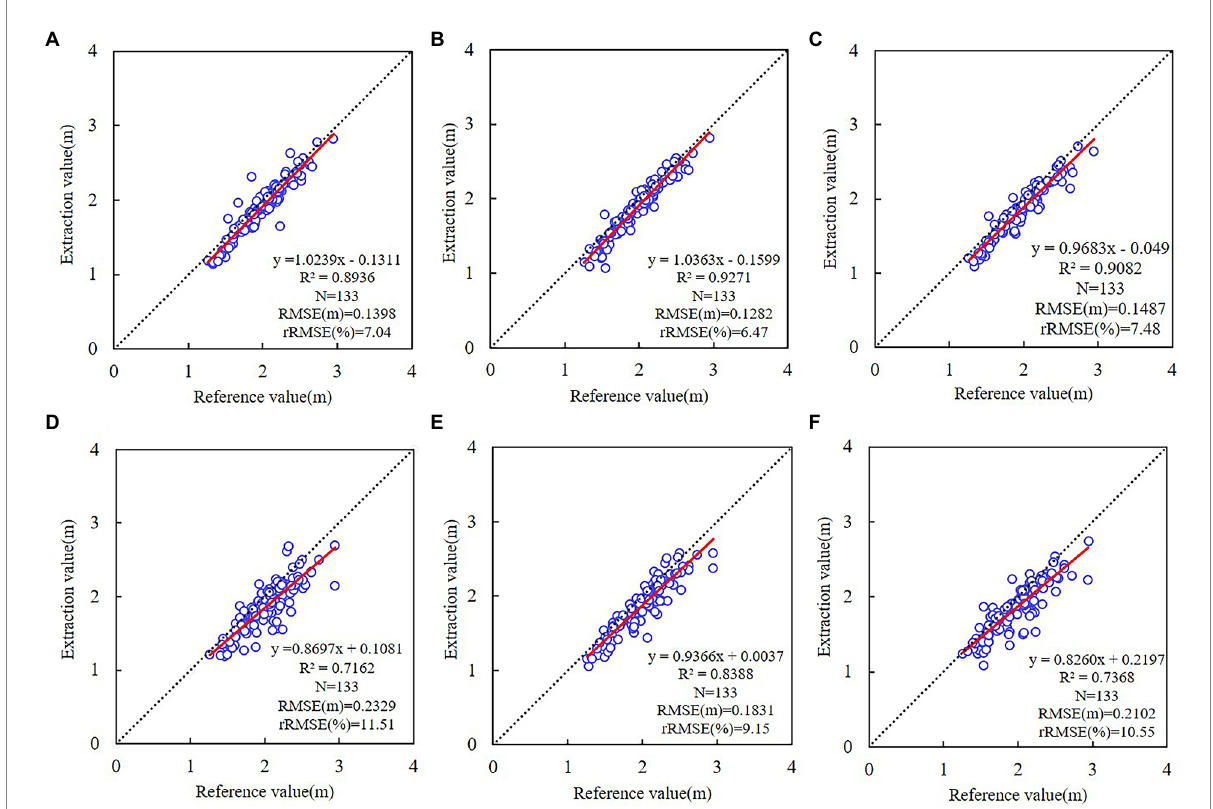
FIGURE 5 Linear regressions of tree-crown width between UAV imagery and different ResU-Net models. (A) RGB; (B) RGB-CHM; (C) RGB-DSM; (D) EXG; (E) EXG-CHM; (F) EXG-DSM. The dotted line represents a 1:1 match, and the red line represents the trend of the tree-crown width relationship based on the ResU-Net model and UAV